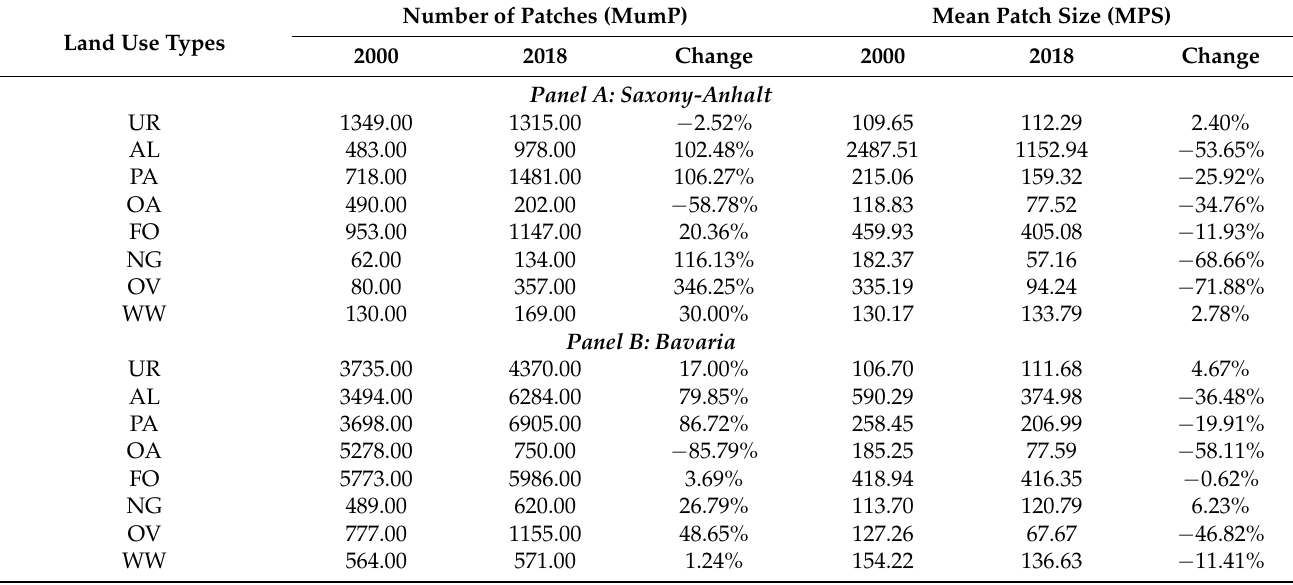
Table 8. The patch number and mean patch size in various land-use classes.